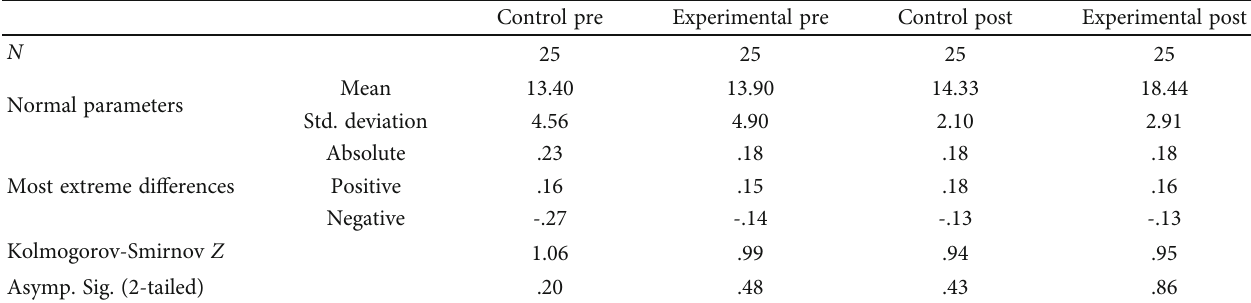
Table 1: One-sample Kolmogorov-Smirnov test (speaking skill).